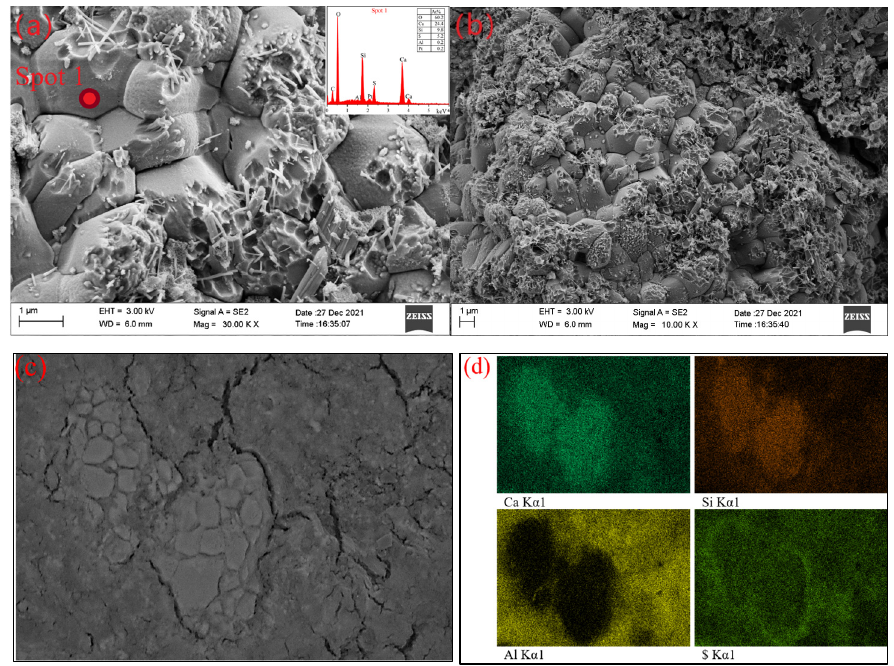
Figure 9. ( a , b ) SEM image of ternesite at 7 d of hydration (on fractured surfaces); ( c ) the selected BSE area of ternesite at 7 d (on polished sections); ( d ) EDS mapping (BSE area). area of ternesite at 7 d (on polished sections); ( d ) EDS mapping (BSE